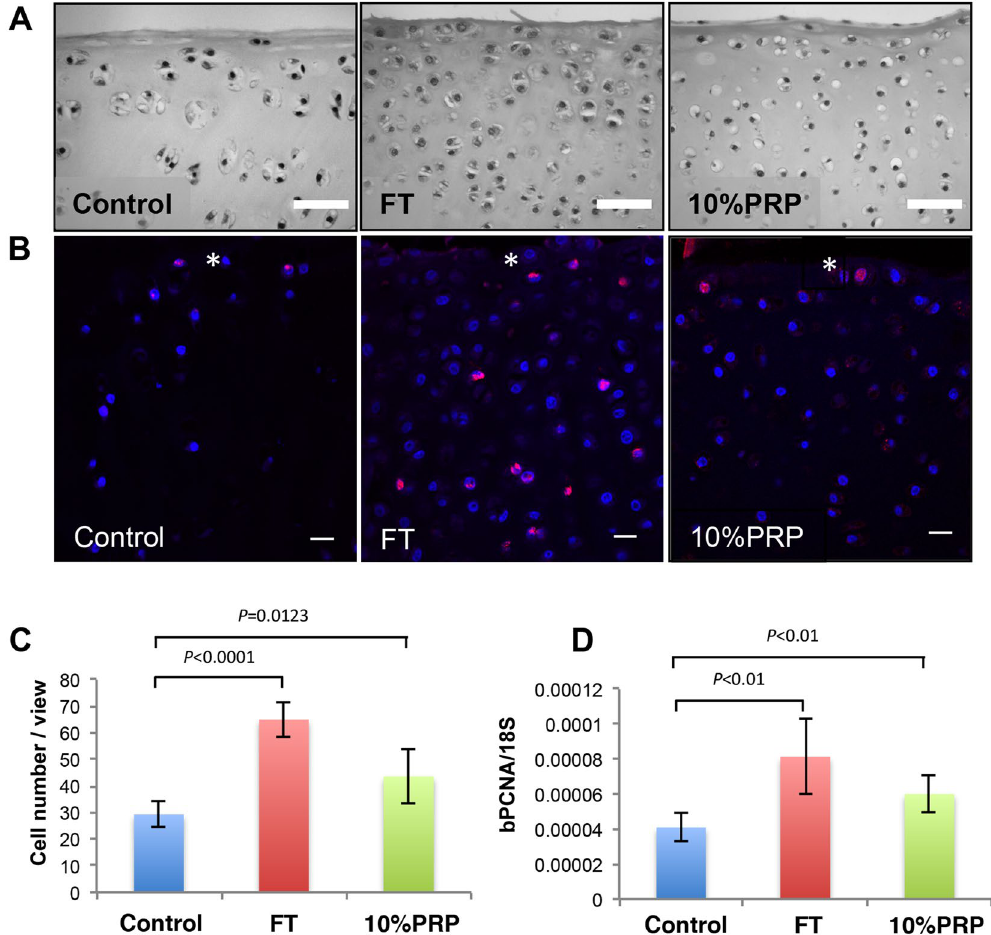
Figure 1. PRP and FGF2-TGF β 1 treatment of immature articular cartilage increases cell number in the surface zone of cultured bovine cartilage explants. 10% PRP lysate or growth factors FGF2 (100 ng ml − 1 ) and TGF β 1 (10 ng ml − 1 ) (FT) were added to serum-free culture medium with immature articular cartilage explants and cultured for 21 days. ( A ) Haemotoxylin and eosin staining of representative sections show the change in cell density at the surface of cartilage explants following treatment. Scale bar equals 50 μ m. ( B ) Explants cultured for 21 days were exposed to 10 μ M BrdU for 24 hours. BrdU-positive labelling was detected using a TRITC- conjugated secondary antibody (red) and nuclei counterstained using DAPI (blue). Cells positive for BrdU were detected as purple/pink labelled nuclei. The white asterisk marks the surface of the cartilage explant. Scale bar equals 20 μ m. ( C ) Graph showing the cell number per microscopic field view (200 μ m × 190 μ m) for treated and untreated immature cartilage (n = 10 per group). ( D ) Graph of gene expression showing the absolute qPCR values for PCNA using 18 S rRNA as housekeeping